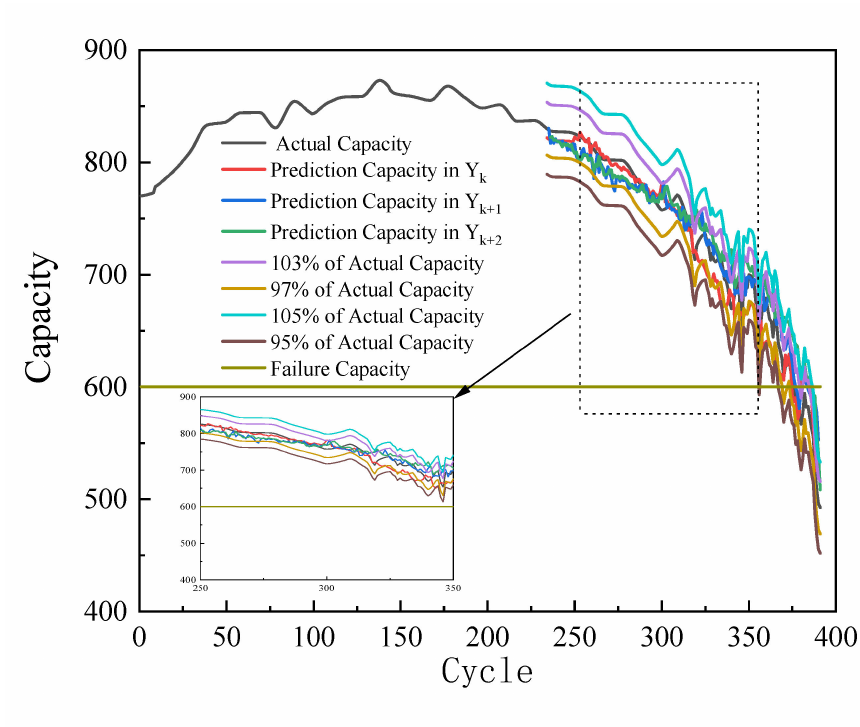
Figure 11. Comparison of forecasting capacity of different models.